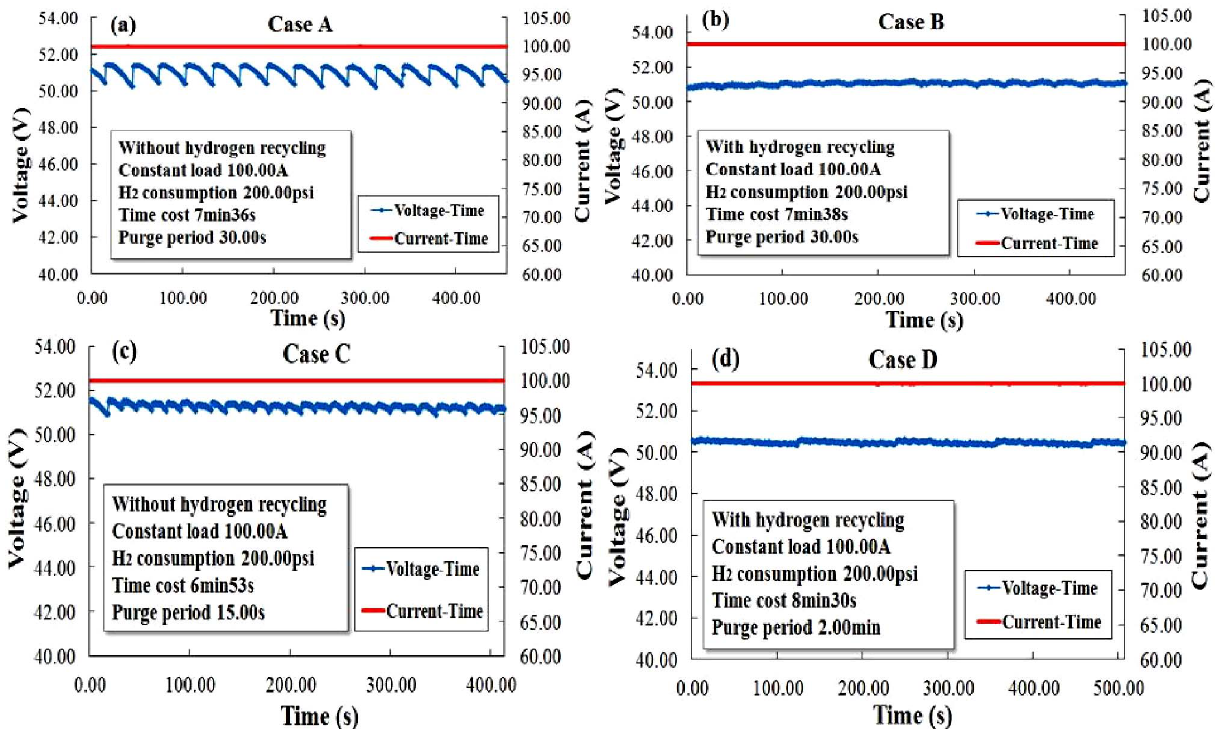
Figure 10. Stack performance under various hydrogen recycling modes and purge periods: ( a ) Case A: without hydrogen recycling-purged period of 30 s; ( b ) Case B: with hydrogen recycling-purged period of 30 s; ( c ) Case C: without hydrogen recycling-purged period of 15 s; and ( d ) Case D: with hydrogen recycling-purged period of 2